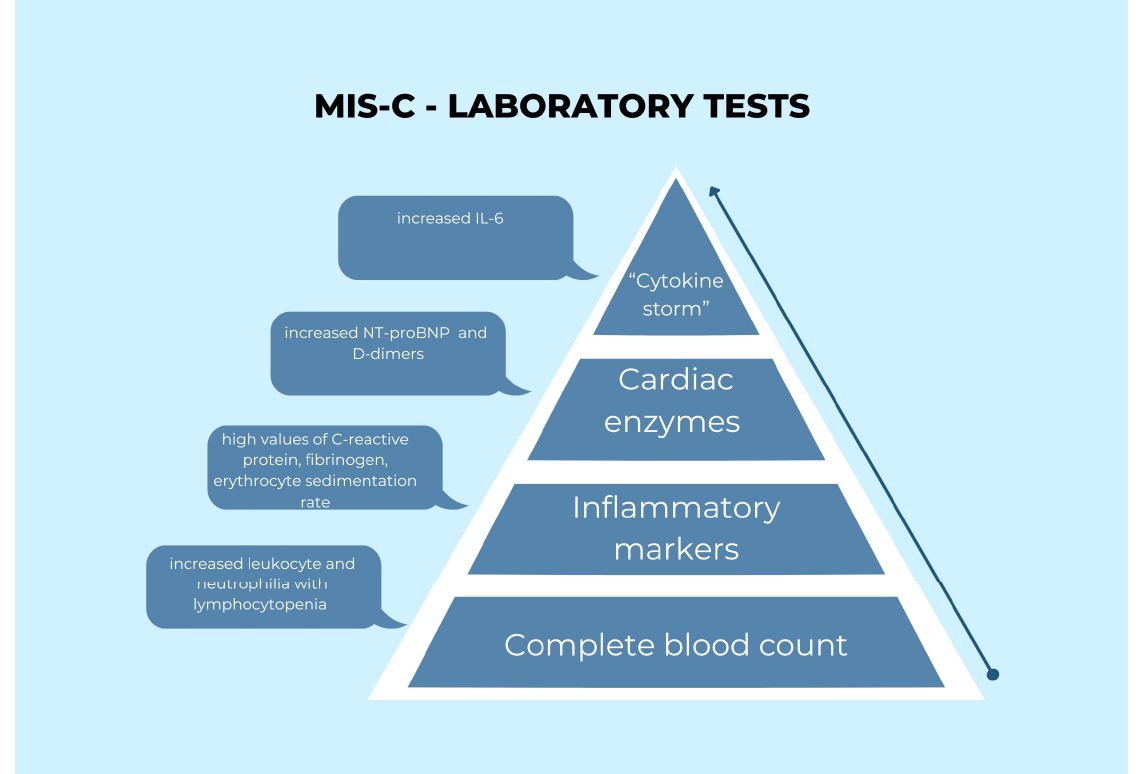
Figure 4. The image presented an illustration of the processes and mechanisms associated with “cytokine storm,” as well as the findings of laboratory experiments.